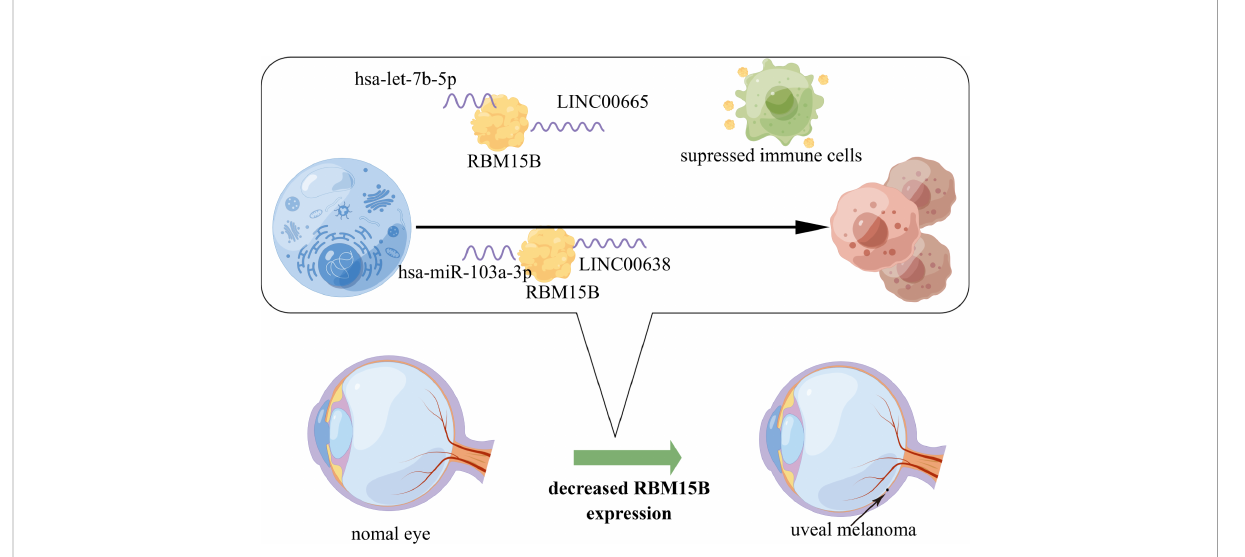
FIGURE 7 The model of regulatory mechanism of RBM15B in carcinogenesis of